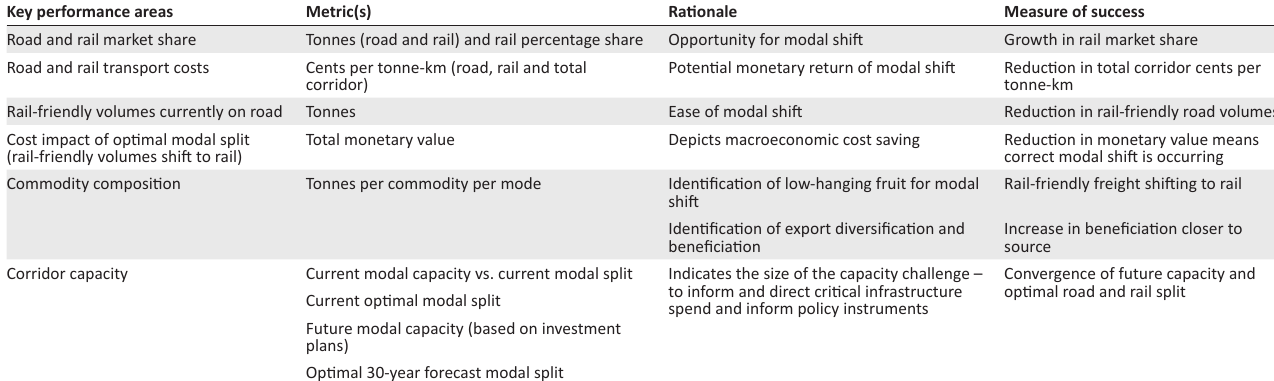
TABLE 2: Multi-modal corridors – policy perspective key performance areas. Key performance